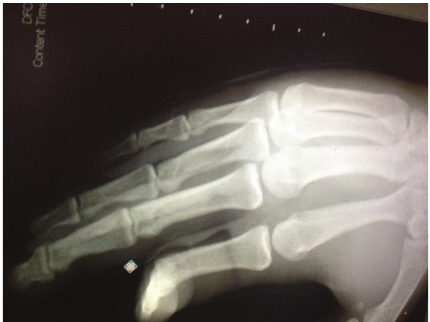
Figure 5: X-ray showing reduced finger.